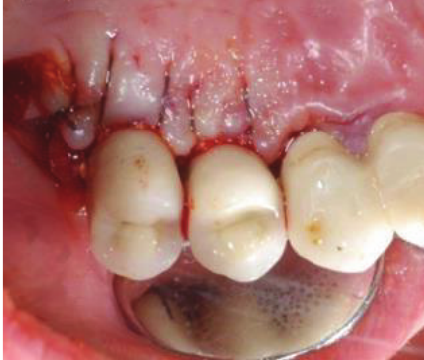
Figure 12: One-year after procedure, an absence of bleeding and reduced probing depth was